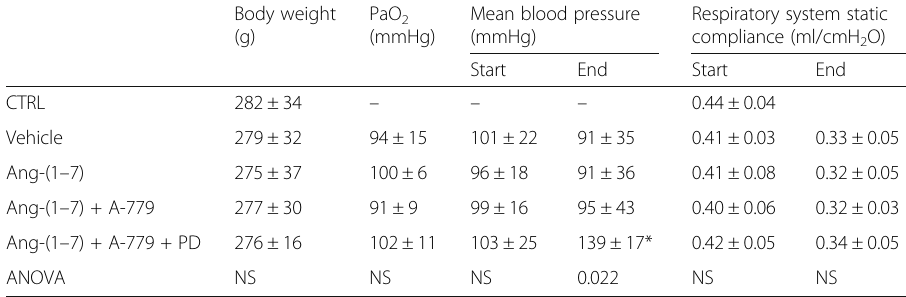
Table 1 Body weight, oxygenation, blood pressure, and compliance during the mechanical ventilation Mean blood pressure Body weight PaO 2 (mmHg) (mmHg) (g) Start End Start End CTRL 282 ± 34 – – – 0.44 ± 0.04 Vehicle 279 ± 32 94 ± 15 101 ± 22 91 ± 35 0.41 ± 0.03 0.33 ± 0.05 Ang-(1 – 7) 275 ± 37 Ang-(1 – 7) + A-779 277 ± 30 0.32 ± 0.03 Ang-(1 – 7) + A-779 + PD 276 ± 16 ANOVA NS NS NS 0.022 NS